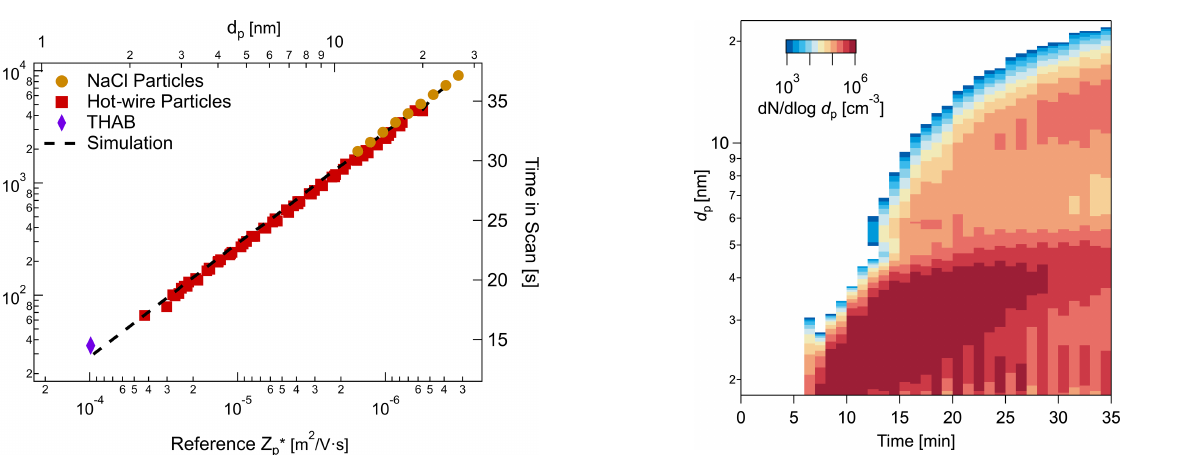
Figure 10. The nSEMS voltage at the peak transmission ( V ∗ ) as a function of the input reference particle mobility, Z ∗ p . Symbols rep- resent experimental results with tetra-heptyl ammonium bromide (THAB), hot-wire, and atomized NaCl particles produced using the setups shown in Fig. 4. The black dotted line demonstrates the volt- age at peak transmission predicted by the finite-element simula- tions. The top axis shows the corresponding particle diameter, d p , at a given mobility, Z ∗ p , as defined in Eq. (1); the right axis shows the corresponding time in the scan.